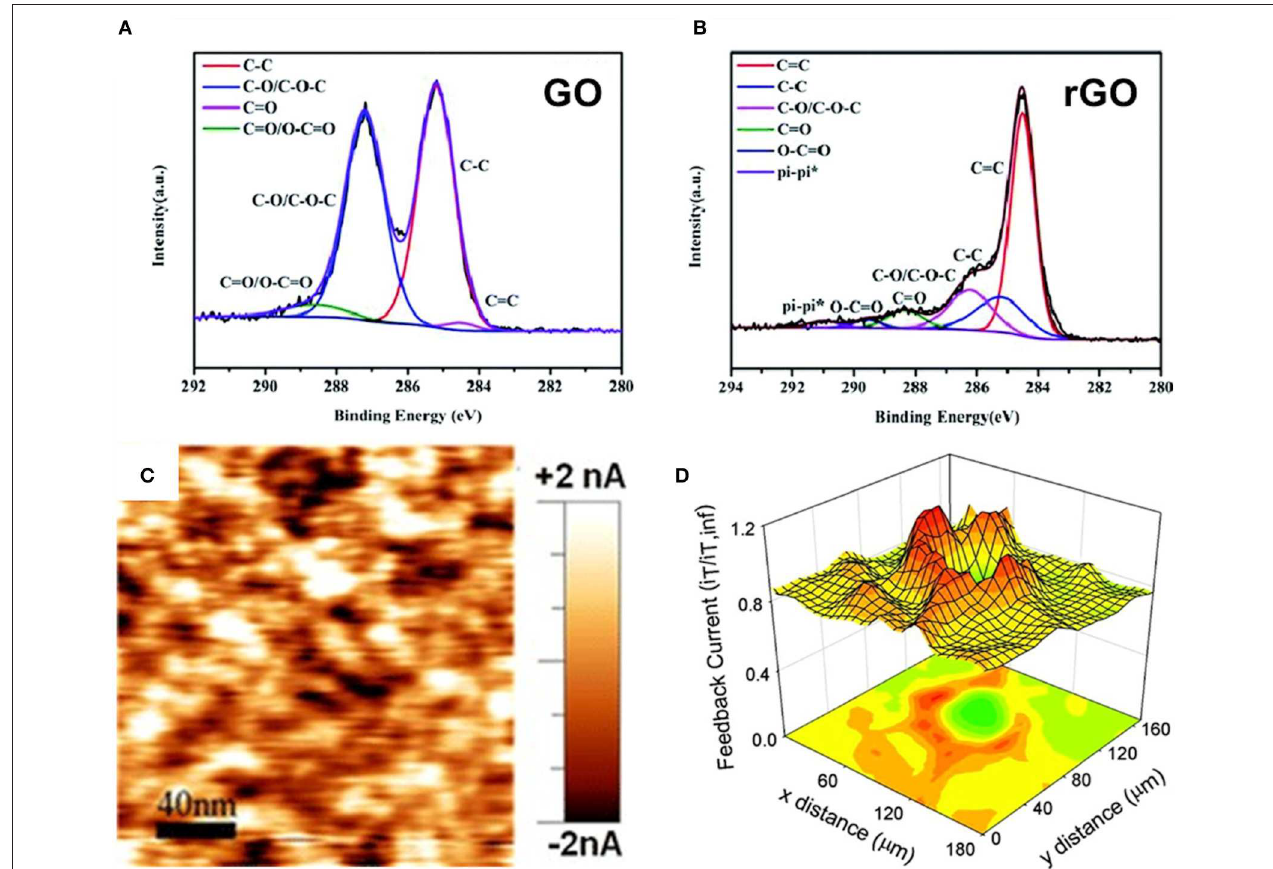
FIGURE 4 | (A) An XPS C1s spectrum of GO with the corresponding C1s spectrum of rGO (B) . (C) A CAFM map of graphene with clear current discontinuity (the darker spots correspond to a lower conductivity). (D) A SECM 3D image of monolayer graphene with higher feedback current around the defect/edges. (A,B) Reproduced under a Creative Commons Attribution (CC BY-NC 3.0) license from Shen et al. (2018). (C) Reprinted with permission from Eckmann et al. (2012). Copyright (2012) American Chemical Society. (D) Reprinted with permission from Tan et al. (2012). Copyright (2012) American Chemical